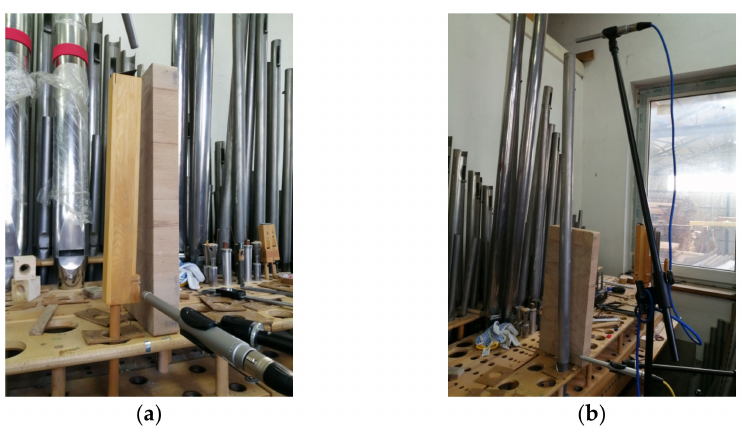
Figure 1. The position of the microphones during recording: ( a ) front view, ( b ) side